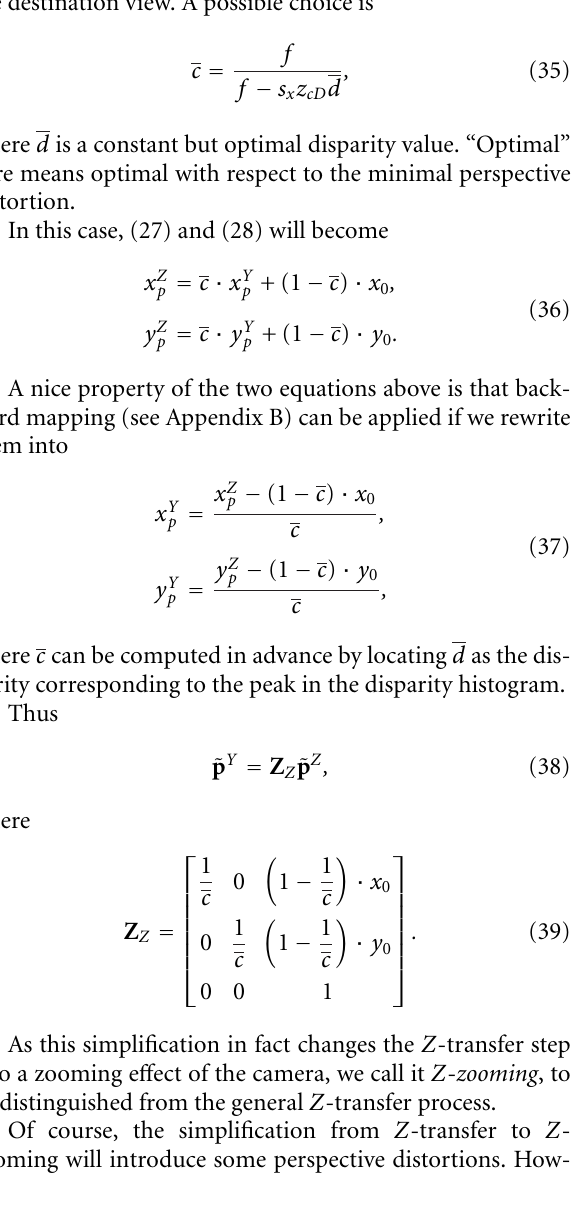
Figure 8: Both the Z -transfer and the Z -zooming are applied on the same Y -extrapolated view. In the Z -transfer, each pixel has a di ff erent transform coe ffi cient. While in the Z -zooming, all pixels are transformed by a uniform optimal scaling factor. The uniform factor is chosen to minimize the possible perspective